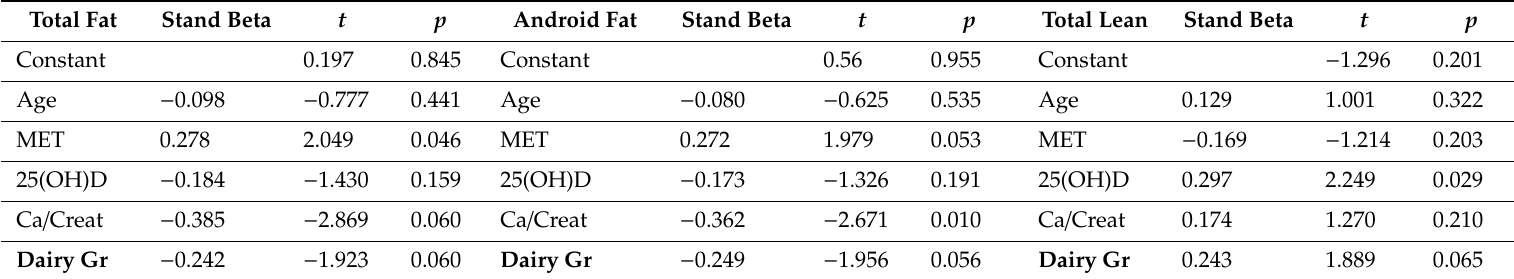
Table 4. Predicting change from baseline to 6 months using Dairy group ( n = 49) compared to Control group ( n = 41) for total fat, android fat and total lean mass and confounders: age, metabolic equivalent (MET), serum 25 hydroxy vitamin D ((25(OH)D), and urinary Ca / Creatinine at baseline.